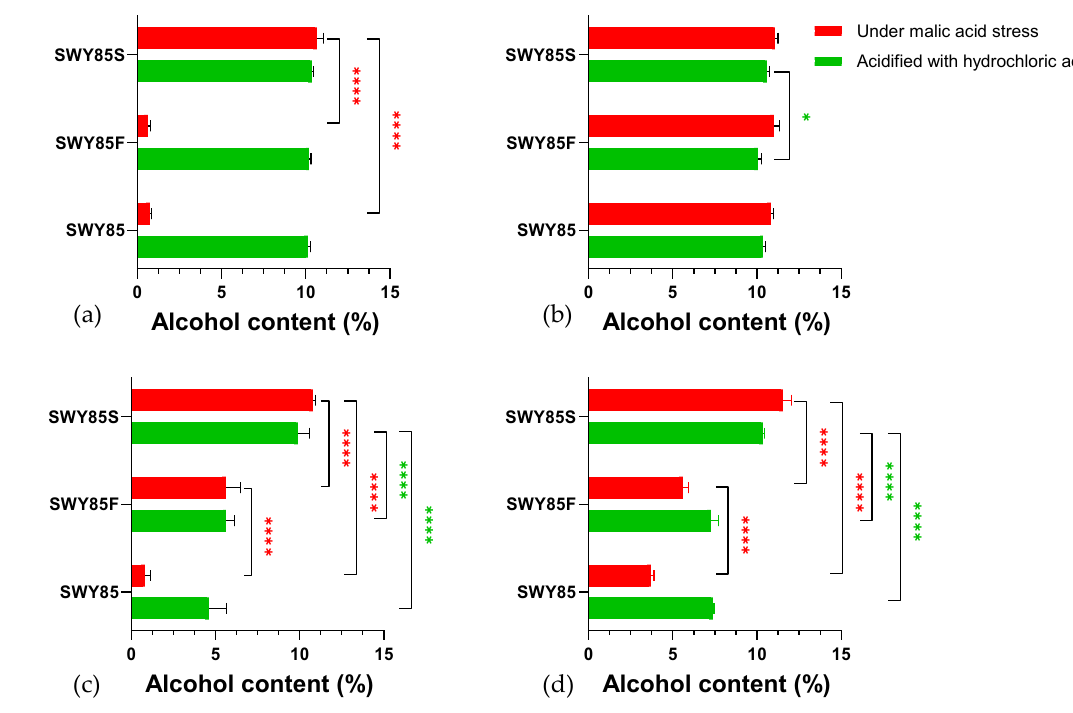
Figure 7. The fi nal alcohol content in the fermented YPD media, under acid stresses at pH 2.7 ( a , b ) and pH 2.5 ( c , d ), respectively. Panel ( a , c ), cell-inoculation fermentations (CIFs). Panels ( b , d ), cell-transferring fermentations (CTFs). * p < 0.05, **** p < 0.0001.